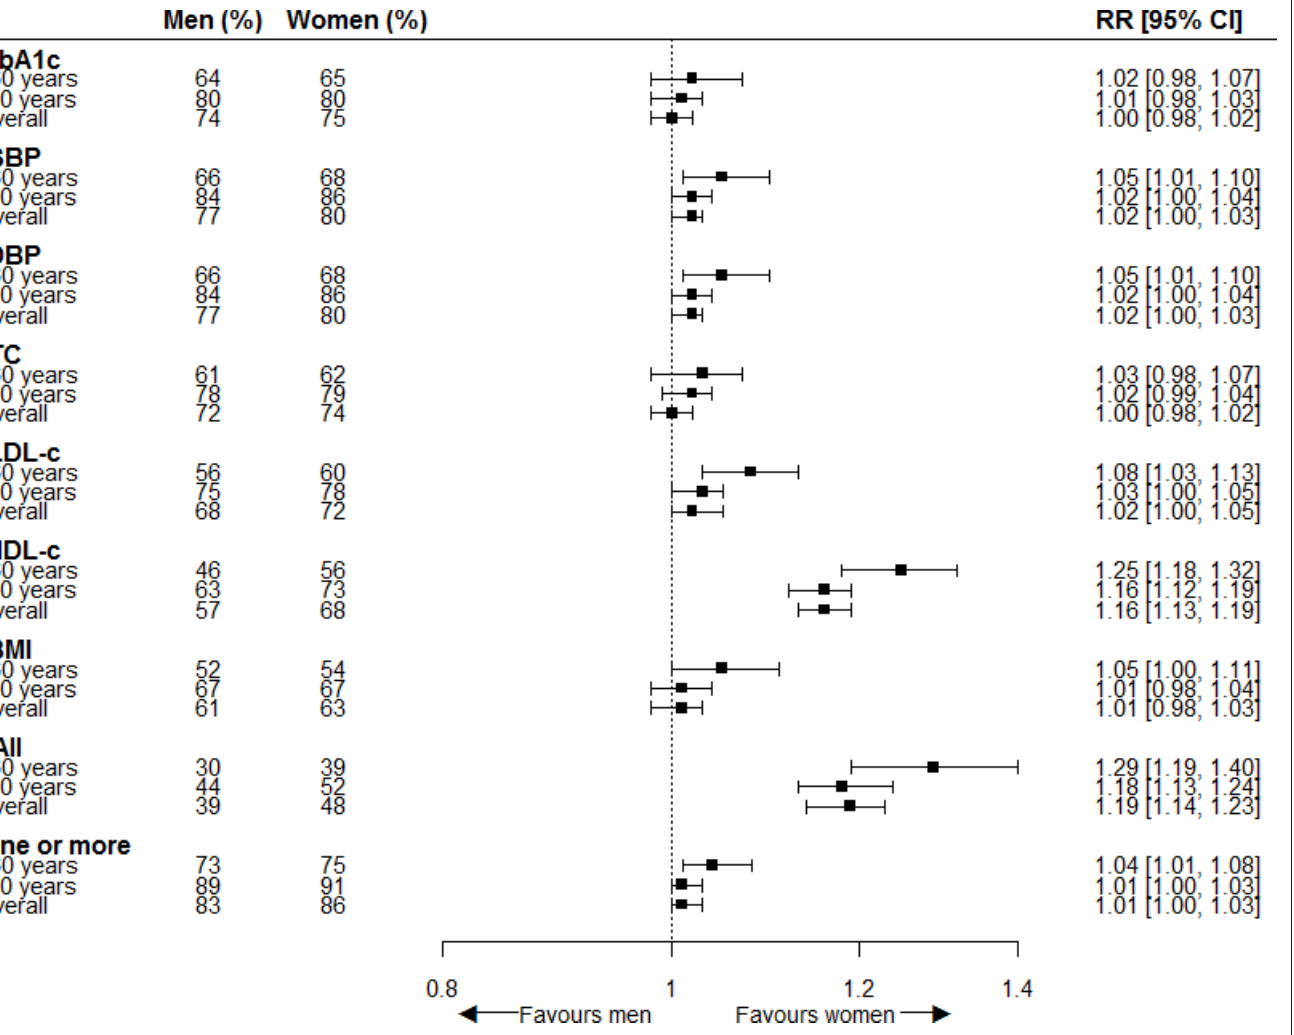
Figure 1 Women-to-men risk ratios for assessment of cardiovascular risk factors. The analyses are adjusted for age. Men = reference category. BMI = body mass index. CI = confidence intervals. DBP = diastolic blood pressure. HDL-c = high-density liproprotein cholesterol. LDL-c = low-density liproprotein cholesterol. RR = risk ratio. SBP = systolic blood pressure. TC = total